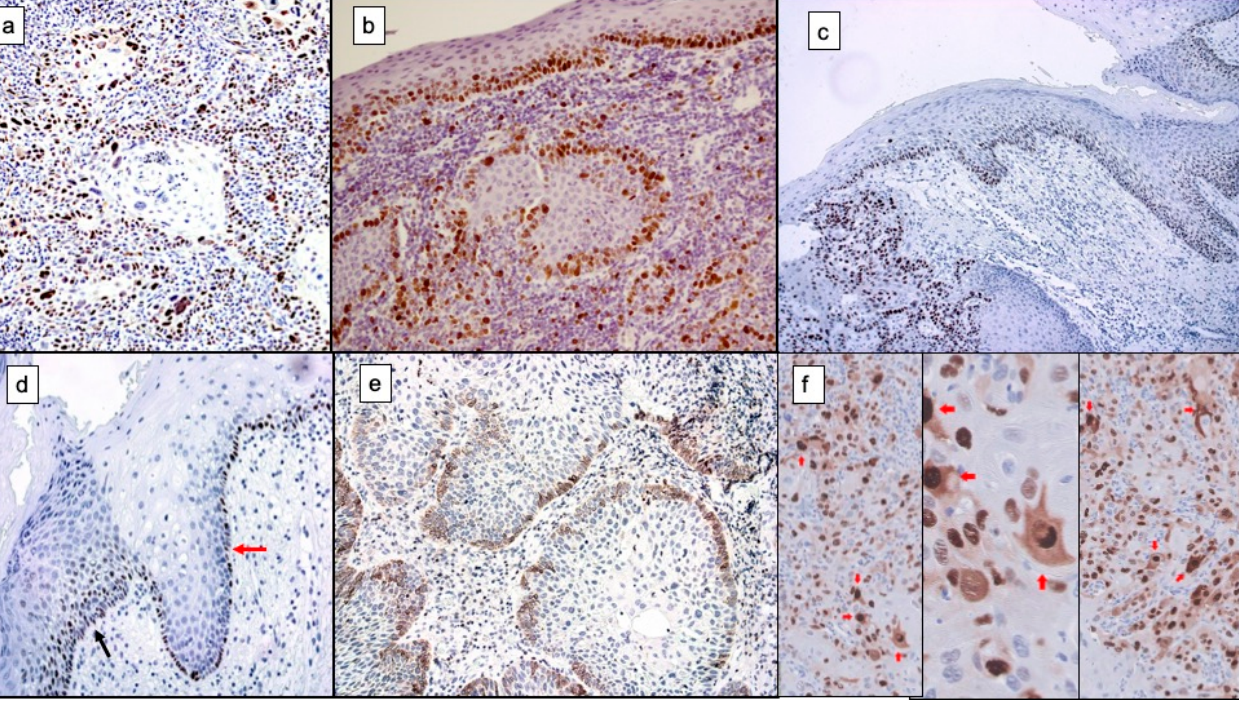
Figure 3. ( a ) Immunohistochemical image of cyclin D1 expression in OSCC. Note the nuclear ex ‐ pression of cyclin D1 at the periphery of the well ‐ differentiated tumour nests (40× magnification). ( b ). Expression of ki67 in oral cancer and adjacent non ‐ tumour epithelium. Note how the cellular proliferative activity of the well ‐ differentiated tumour nests is very similar to that observed in the non ‐ tumour oral epithelium (40× magnification). ( c ). Immunohistochemical overexpression of p53 protein in oral cancer and adjacent non ‐ tumour epithelium. Note the early overexpression of p53 in premalignant epithelium (20× magnification). ( d ). Detail of Figure 3c. Note the overexpression of p53 in the premalignant epithelium adjacent to the carcinoma in which in the right area (red arrow) protein expression is observed in the basal layer, while in the left area (black arrow) protein overex ‐ pression is observed in the basal and suprabasal layers of the epithelium, which also shows a mor ‐ phological alteration compatible with epithelial dysplasia (40× magnification). ( e ). Immunohisto ‐ chemical expression of bcl ‐ 2 in the periphery of well ‐ differentiated tumour nests (40× magnifica ‐ tion). ( f ). Cytoplasmic cyclin D1 expression. Note that some cells show an amoeboid form of inva ‐ sion probably due to the development of actin ‐ based structures (lamellipodia and invadopodia) (40×, 200× and 40×, magnification, respectively).